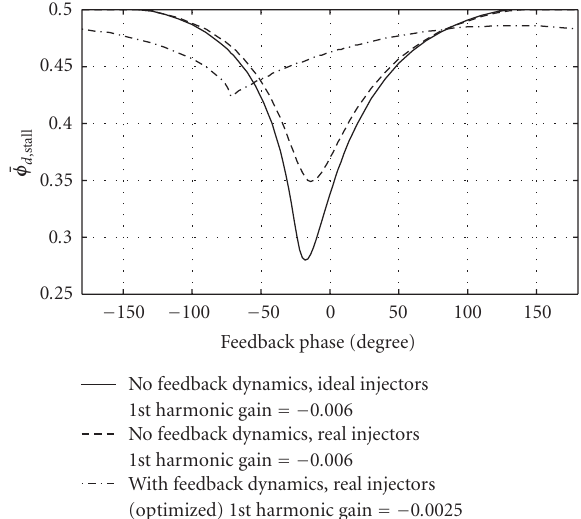
Figure 8: Theoretical predictions of the downstream flow coe ffi - cient at stall for first spatial harmonic control with an optimum feedback gain and varying feedback phase for various levels of mod-